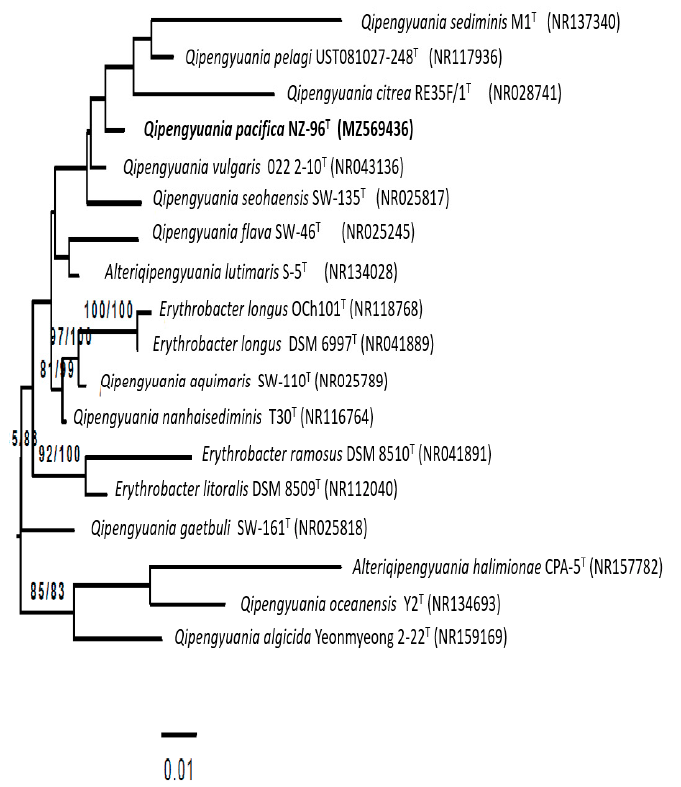
Figure 2. Maximum-likelihood phylogenetic tree based on almost complete 16S rRNA gene sequence of strain NZ-96 T and its most closely related species, inferred under the GTR+GAMMA model. The numbers above the branches are support values when larger than 60% from ML (left) and MP (right) bootstrapping. Bar 0.01 substitution per nucleotide position.